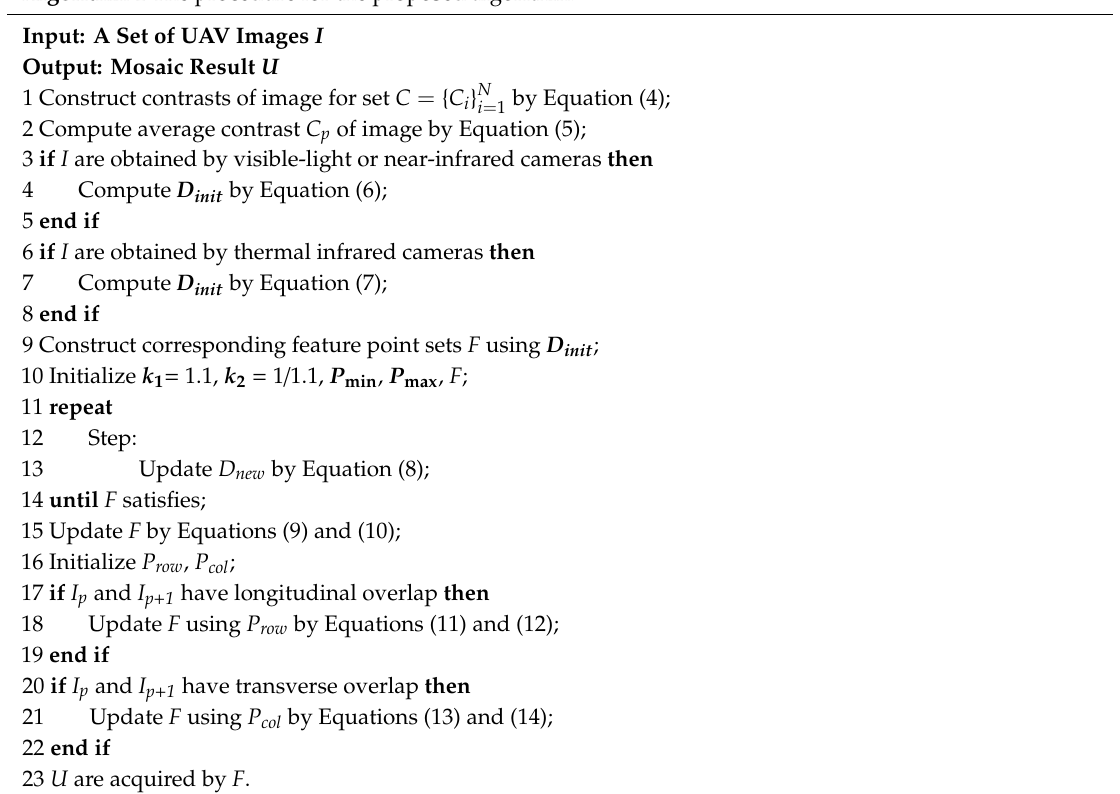
Algorithm 1 The procedure for the proposed